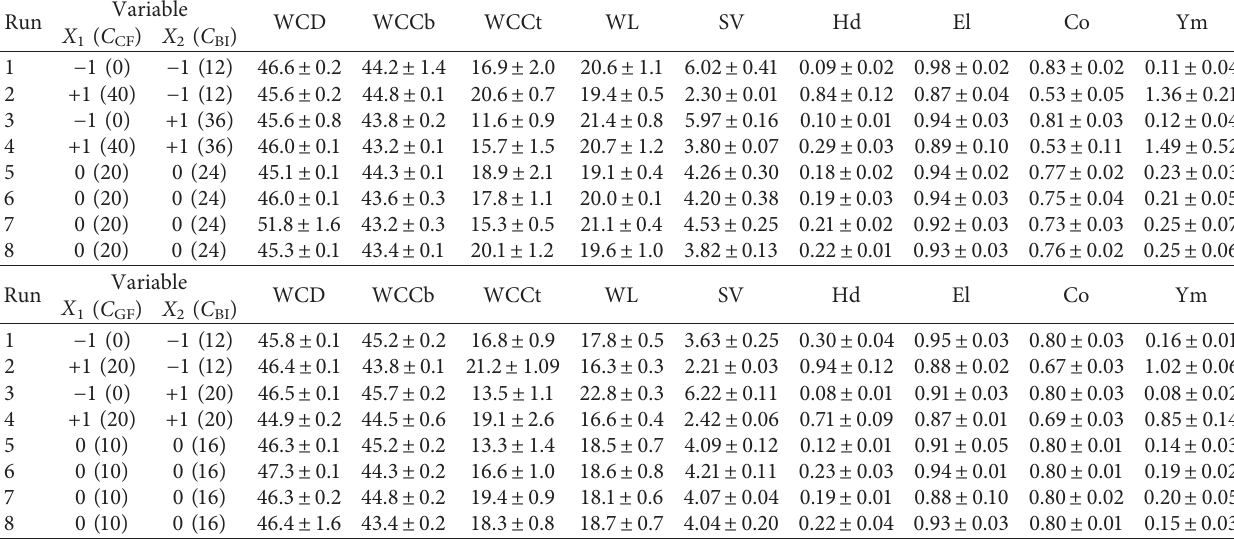
Table 1: The 2 2 factorial design and responses in the characterization of bread produced with different concentrations of wheat flour, corn flour ( C CF � g/100g total flour), green banana flour ( C GF � g/100 g total flour), and baking improver ( C BI � g/1200g total flour).